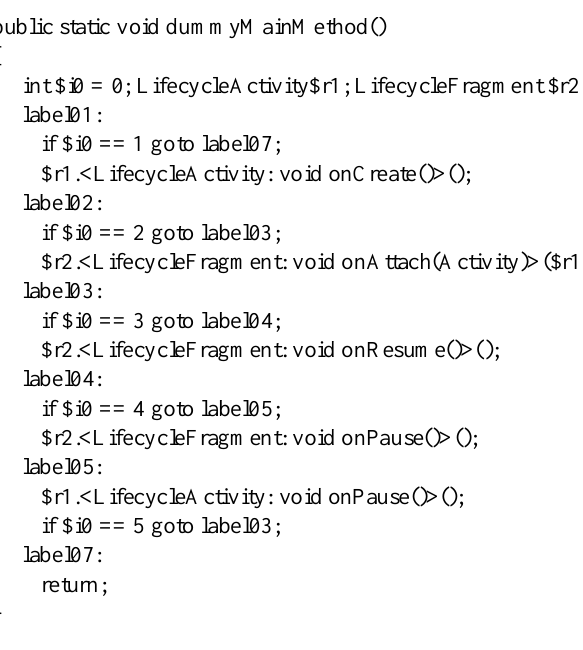
Figure 6. Dummy Main Method IR Code of Motivation